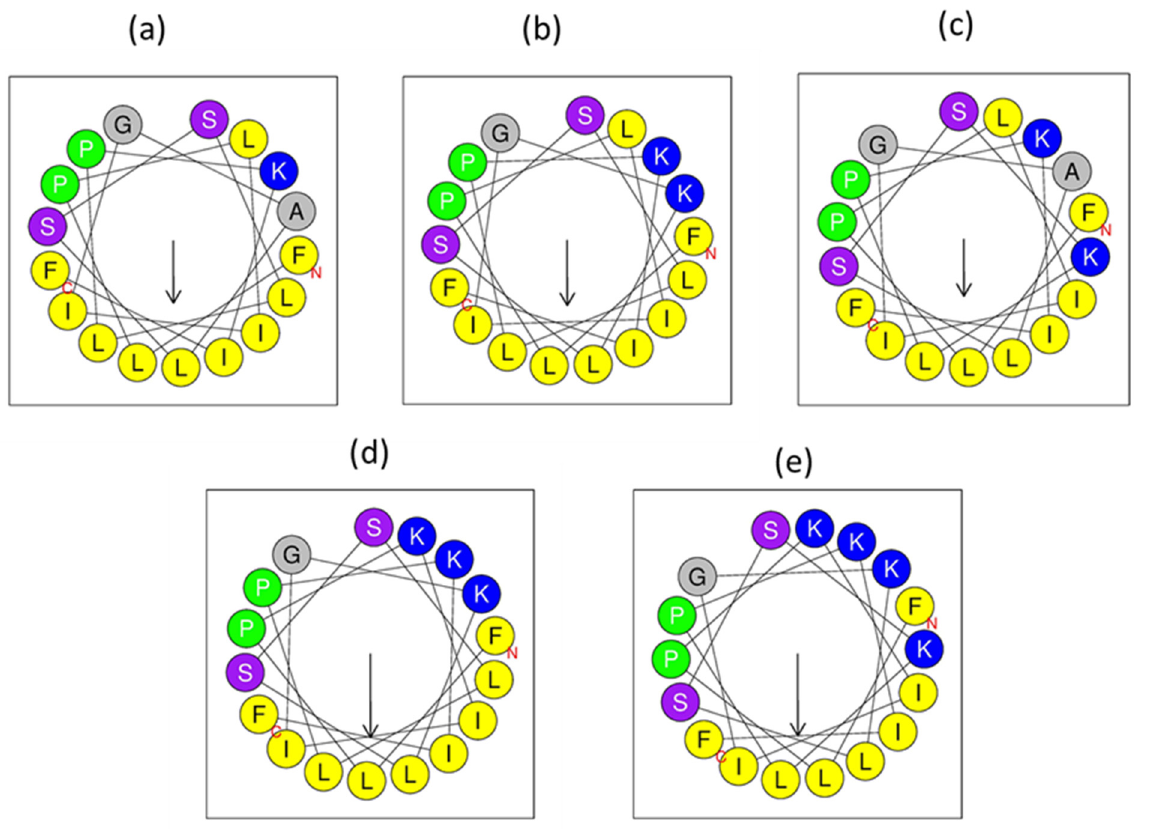
Figure 4. The helical wheel representations of ( a ) temporin-PKE, ( b ) temporin-PKE-2K, ( c ) temporin- PKE-K 12 , ( d ) temporin-PKE-3K, and ( e ) temporin-PKE-4K, as predicted by HeliQuest. The hy- drophobic, hydrophilic, and positively charged amino acids are coloured in yellow, purple, and blue,